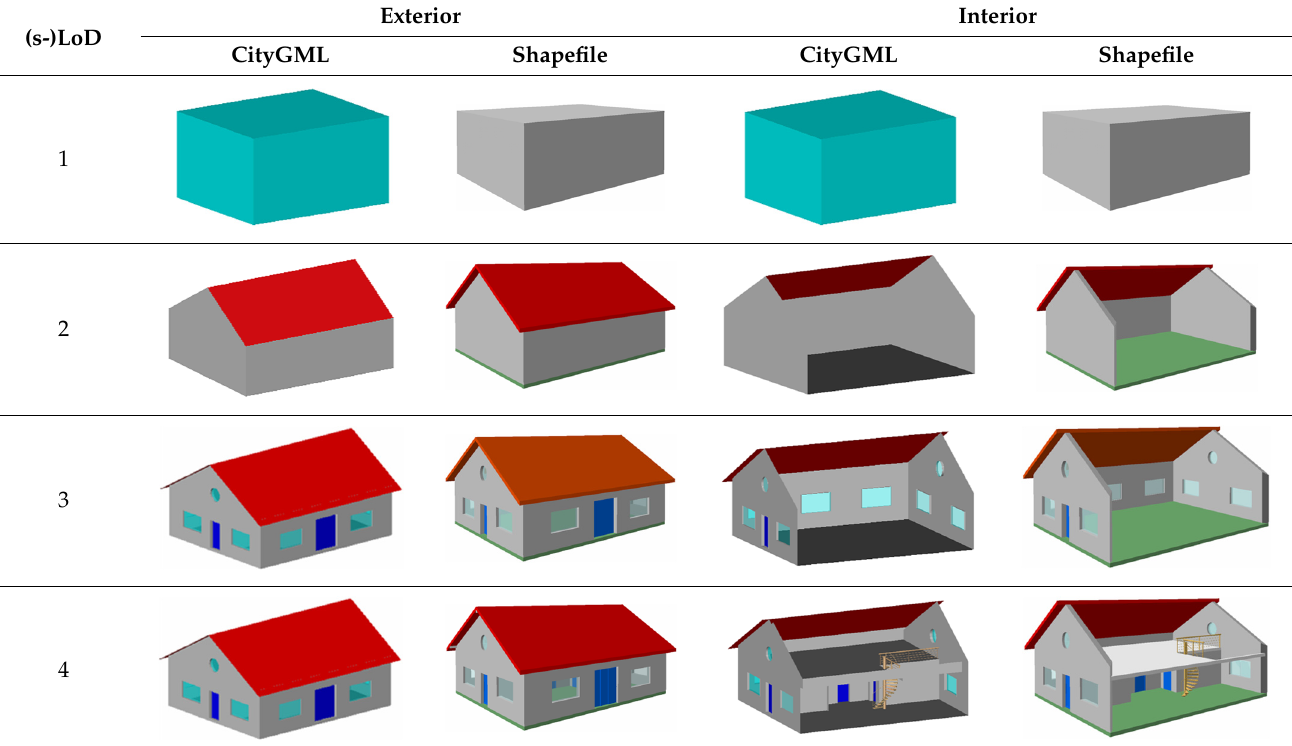
Table 12. CityGML and shapefile models from (s-)LoD1 to (s-)LoD4.